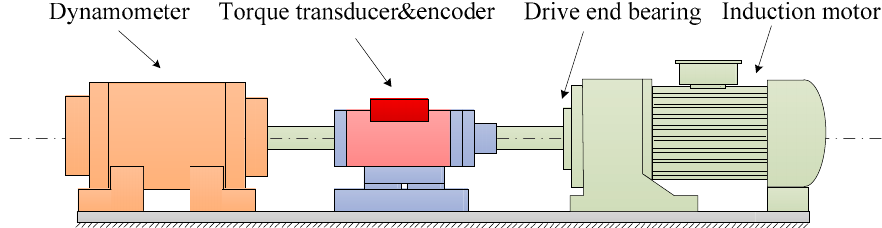
Figure 5. Bearing experimental platform of CWRU.